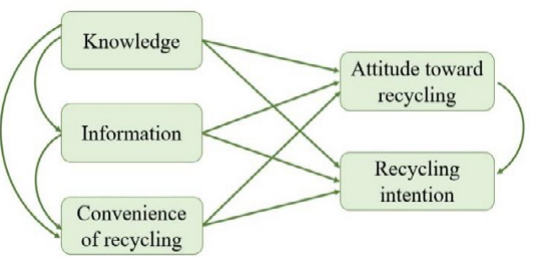
Fig. 1: The study framework